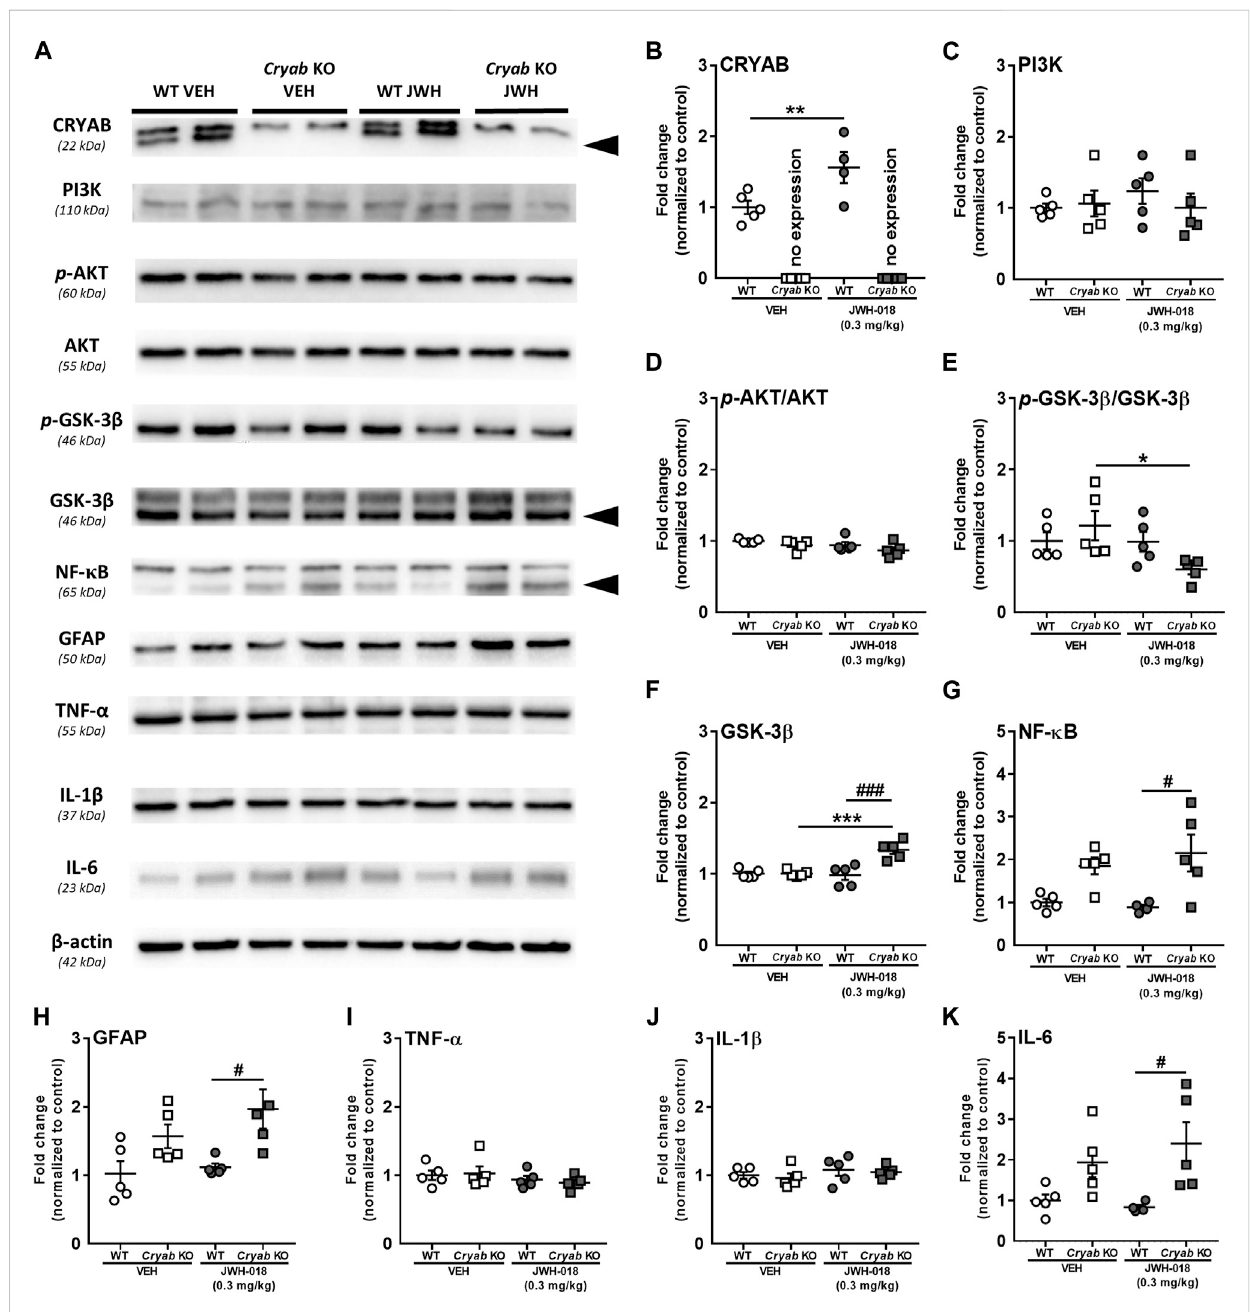
FIGURE 5 ExpressionofProteinexpressionsalongthePI3K-AKT-GSK3pathwayandin fl ammation-relatedproteinsinwild-type(WT)and Cryab knockout(KO) mice following JWH-018 exposure. (A) Representative blots showing the expression of target proteins in mice STR. Western blotting revealed the expressionlevelsof (B) CRYAB, (C) PI3K, (D) p -AKT, (E) GSK-3 β , (F) p -GSK-3 β , (G) NF- κ B, (H) GFAP, (I) TNF- α , (J) IL-1 β ,and (K) IL-6intheSTRofJWH-018- treated mice. n = 4 – 5. Data expressed as mean ± S.E.M. * p < 0.05, ** p < 0.01, and *** p < 0.001 (vs. VEH; Tukey ’ s post hoc analysis). # p < 0.05 and ### p < 0.001 (vs. WT; Tukey ’ s post hoc